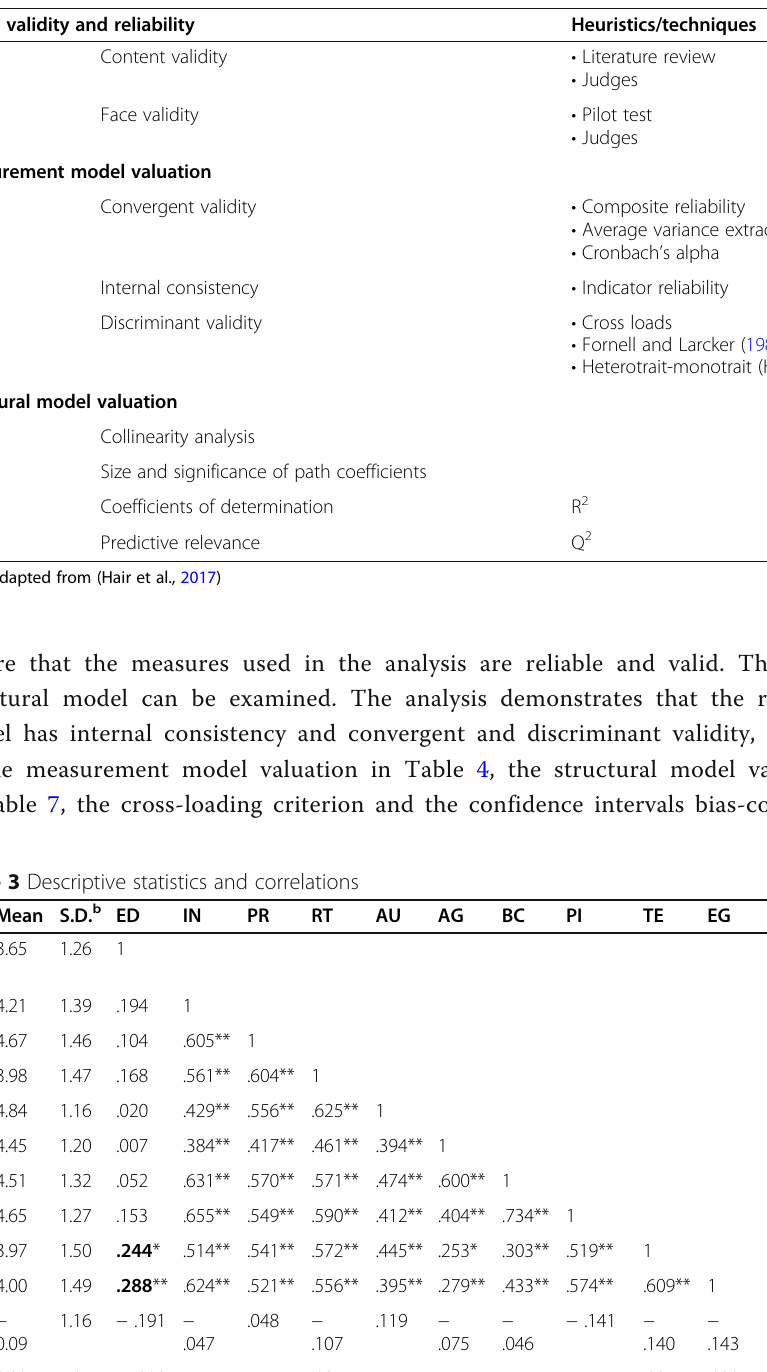
Table 2 Measurement and structural model